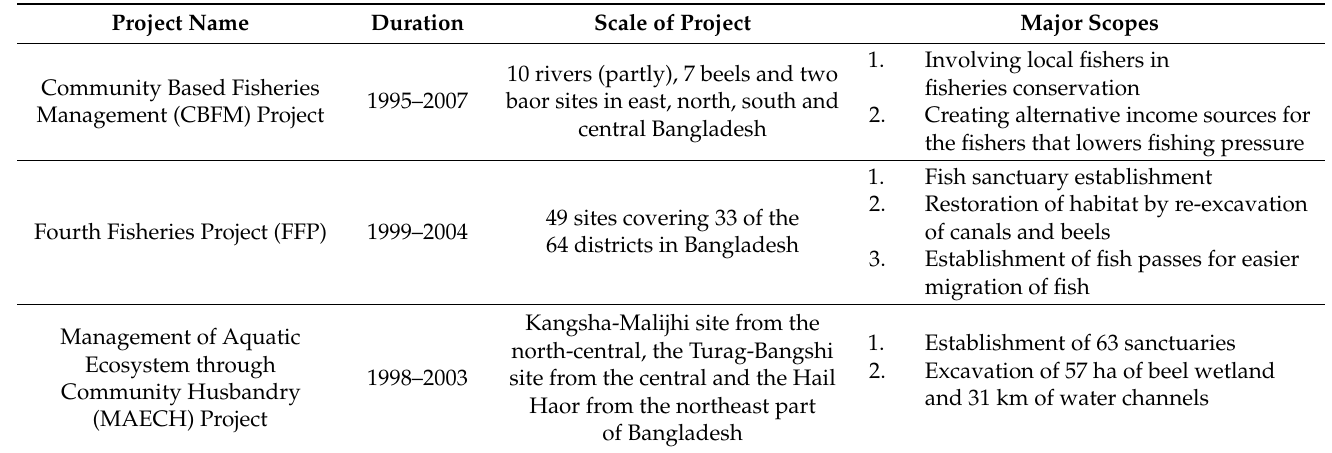
Table 6. List of the major projects for the conservation of inland fisheries